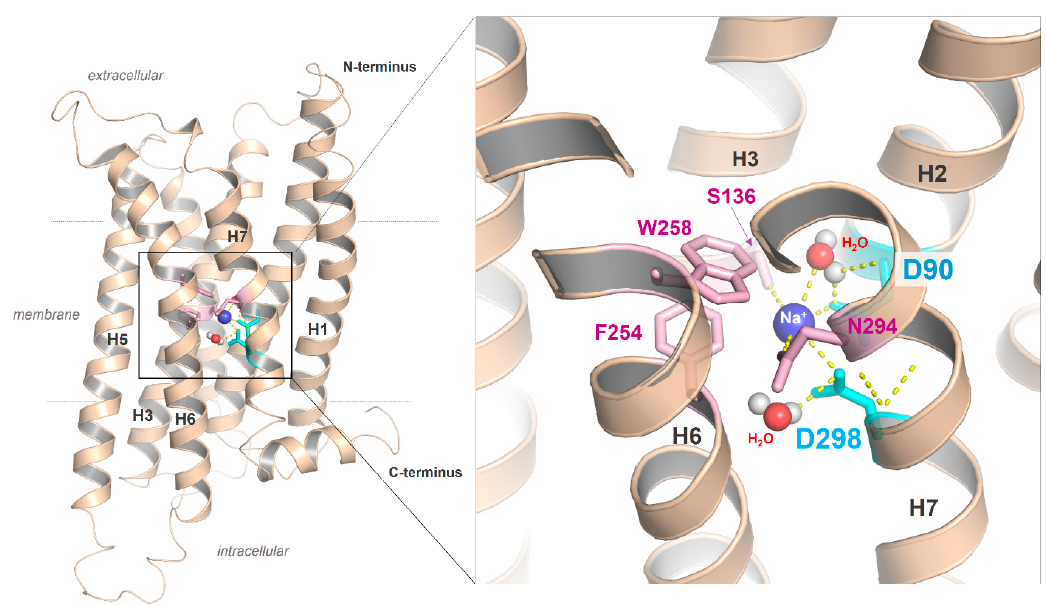
Figure 5. The putative sodium binding site with two aspartates in the MC4R. Sequence specificity of MCRs is a negatively charged aspartate in the DPxxY motif of transmembrane helix (H) seven, whereas in most class A GPCRs, an asparagine (NPxxY) is usually present. The MC4R aspartate in TMH7 could affect the ion binding properties of the MC4R, including the H-bond network with water molecules or the exact spatial location of the cation. In addition to the two aspartates located in TMH2 and TMH7, further amino acids, such as those from helix 3 (e.g., S136), are involved in the formation of the sodium binding site.